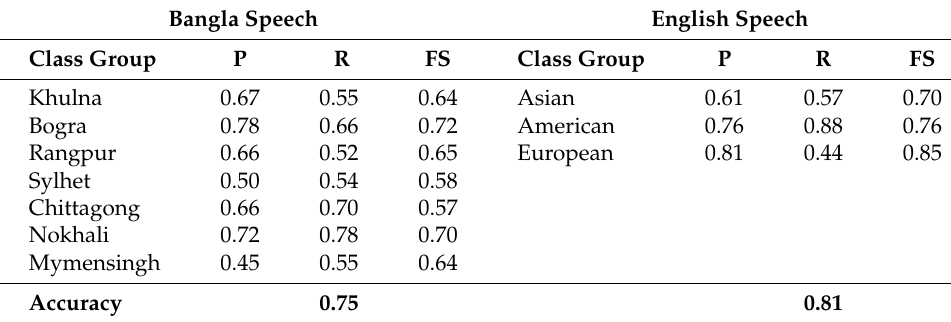
Table 4. Classification Results of Dialect for both Bangla and English Speech Precision (P), Recall (R), and f1-score (FS) using the SCAE-MLELMs